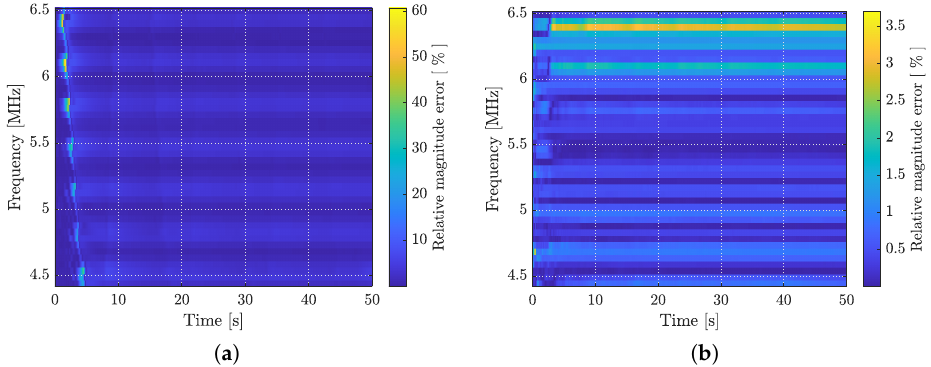
Figure 11. Incident wave magnitude error from the extended Kalman filter. ( a ) Test 1. ( b ) Test